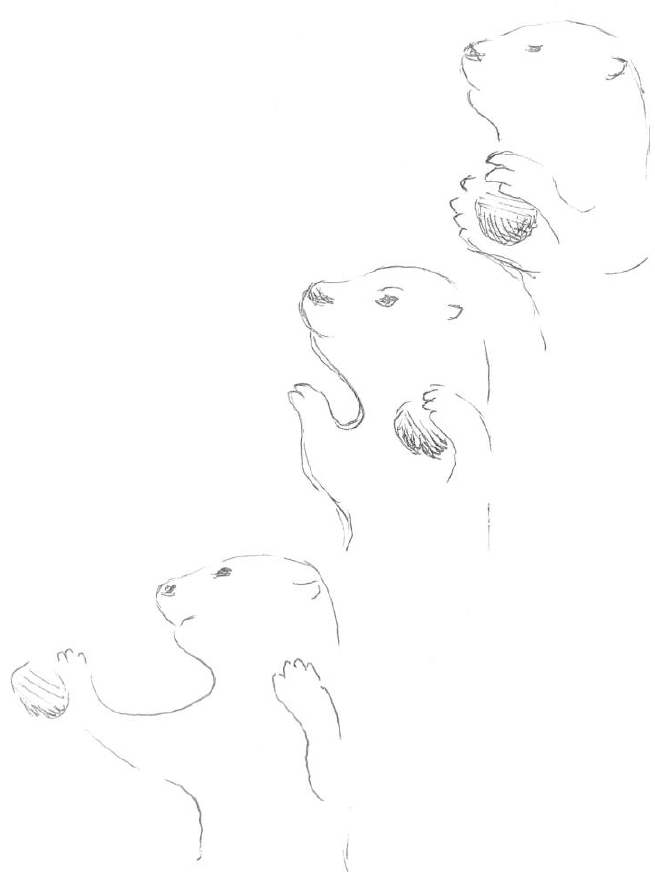
Artistic Rendition by M.B. of an Otter Practicing Stone Handling